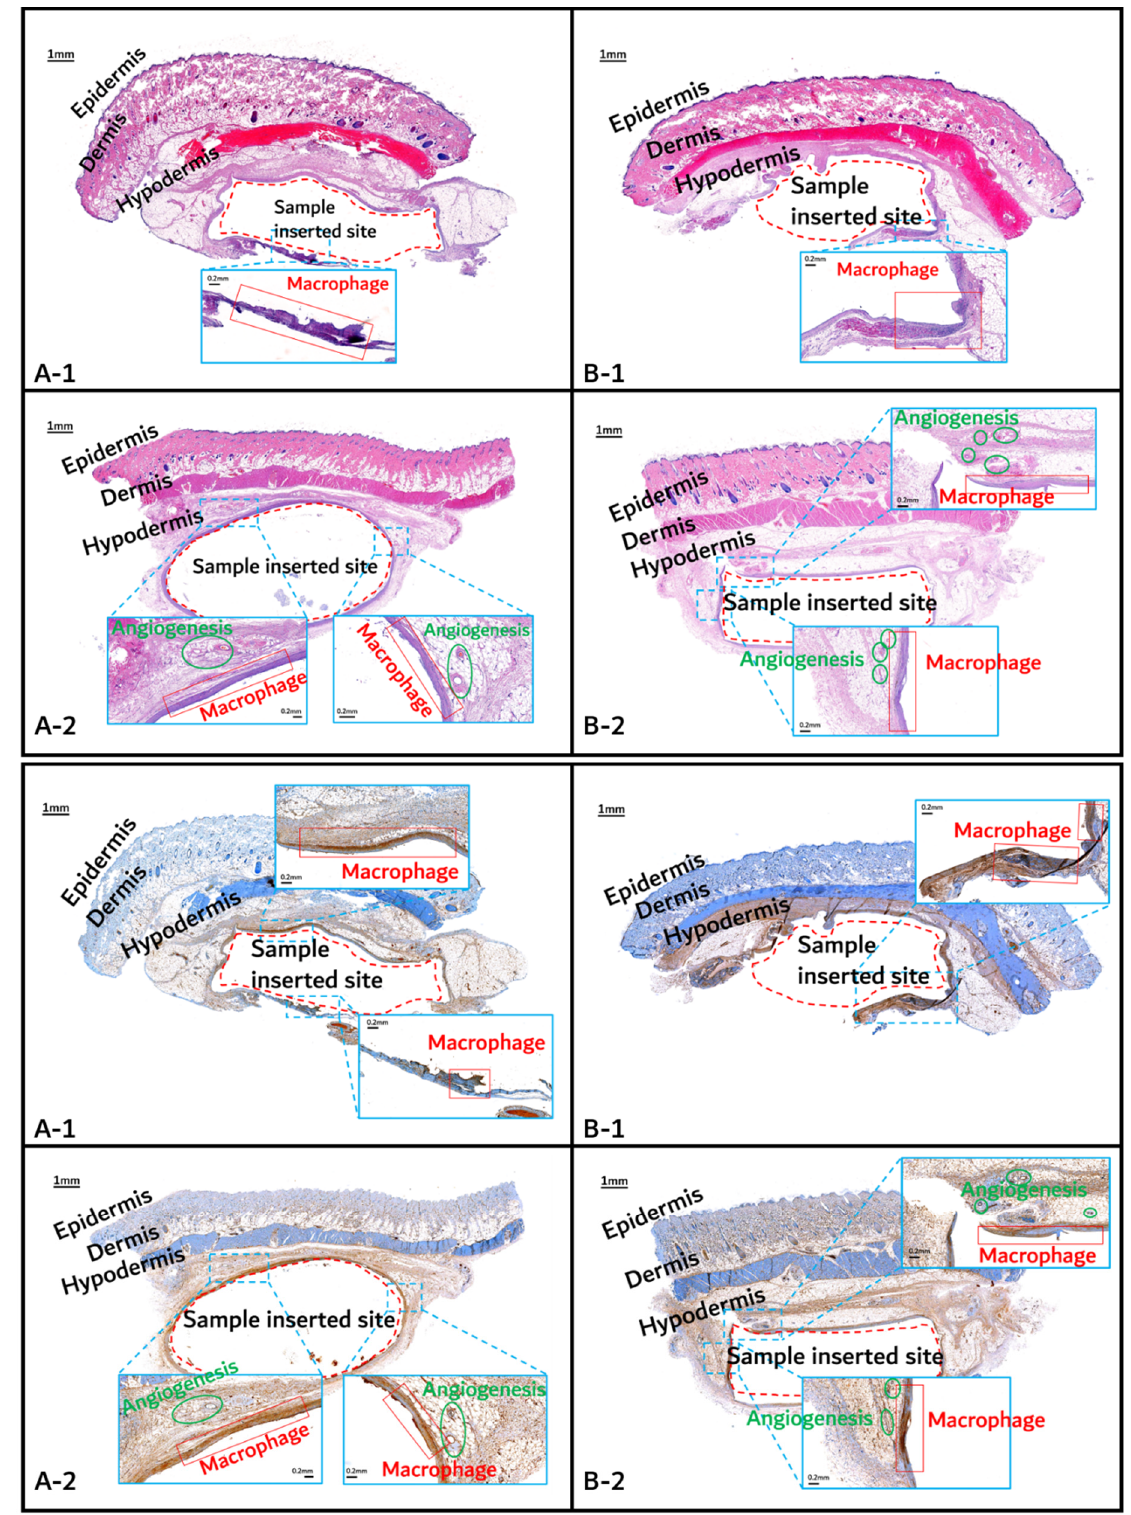
Figure 11. Histochemical analysis (upper: H&E staining, below: immunostaining) of in vivo animal degradation test. ( A-1 , 2 : tissue around a PLGA sample which 1 and 2 months, B-1 , 2 : tissue around a PGA–PLA block copolymer sample that was inserted at 1 and 2 months).